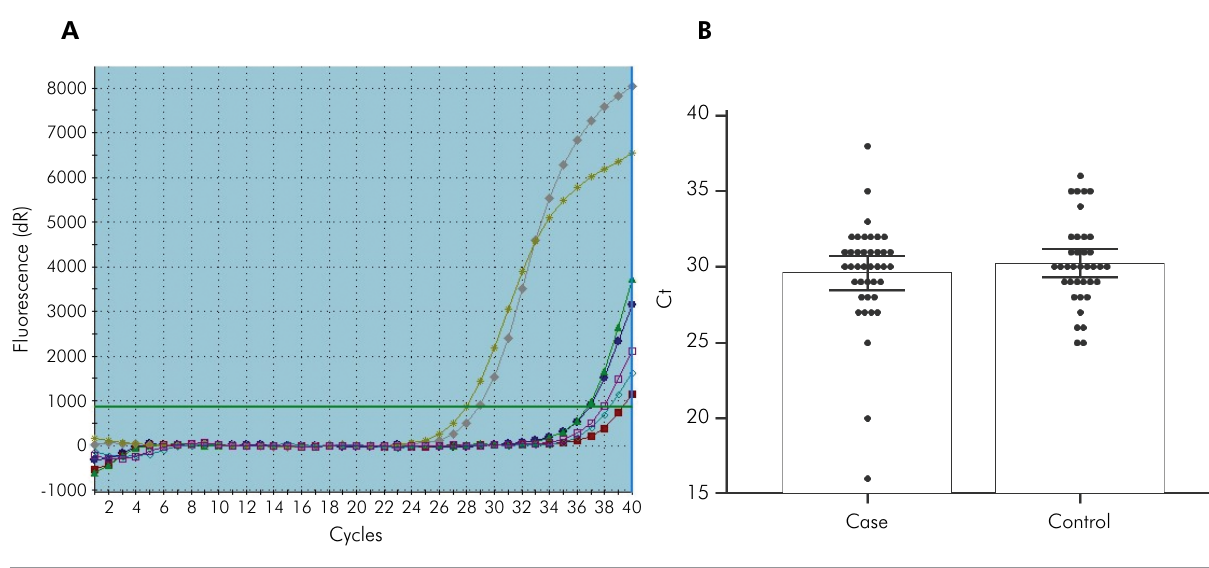
Figure 2. (A) UniSp6 rRNA expression detected in a representative healthy control. (B) The mean Ct values (mean ± SE) of UniSp6 rRNA in the case and control groups. Each black dot indicates the Ct value of each